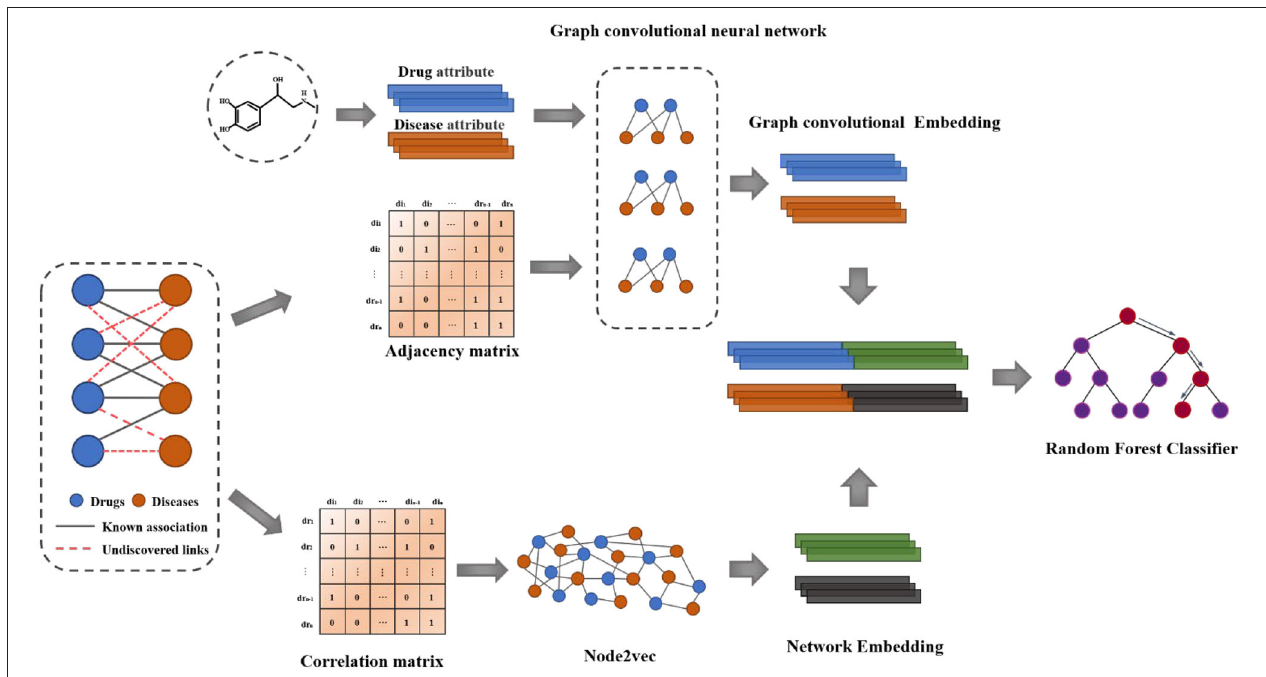
FIGURE 1 | Flowchart of the proposed